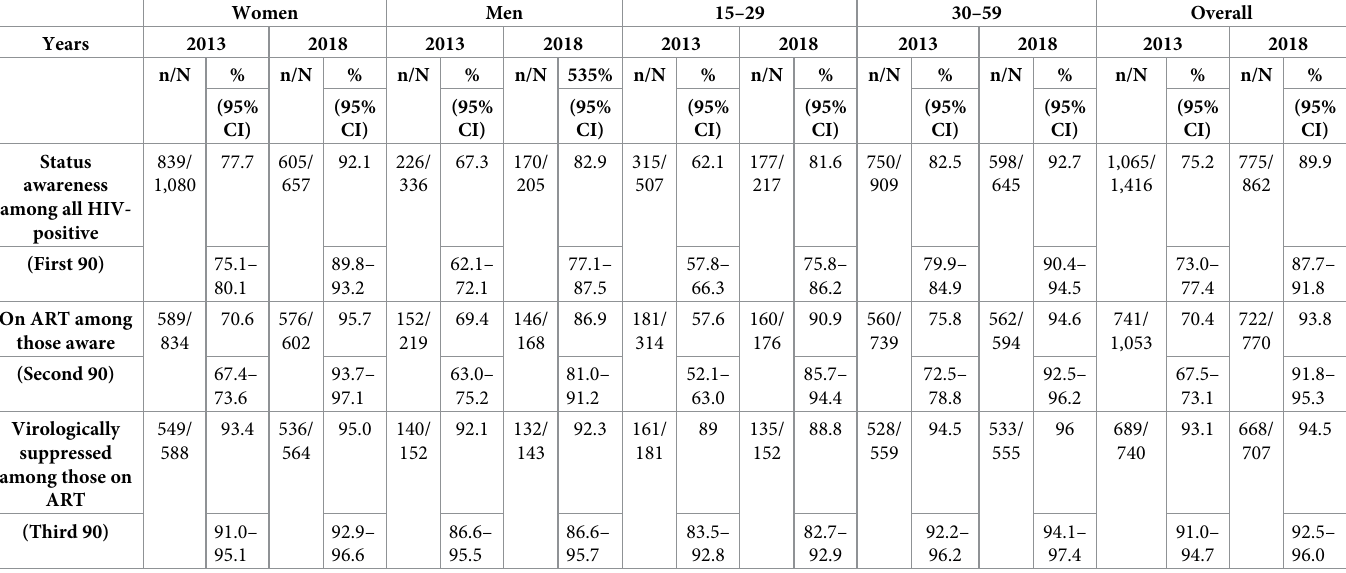
Table 3. UNAIDS 90-90-90 target results, stratified by sex and age group, 2013 and 2018